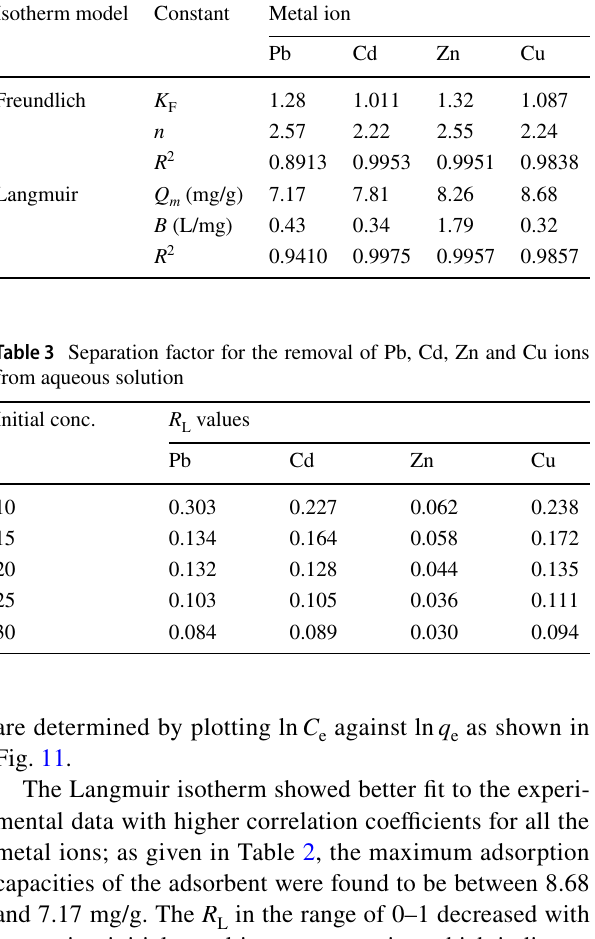
Fig. 11 Freundlich isotherm for Pb(II), Cd(II), Zn(II) and Cu(II) ion removal at various concentrations Table 2 Freundlich and Langmuir isotherm constants for the removal of Pb, Cd, Zn and Cu ions from aqueous solution by Albizia lebbeck